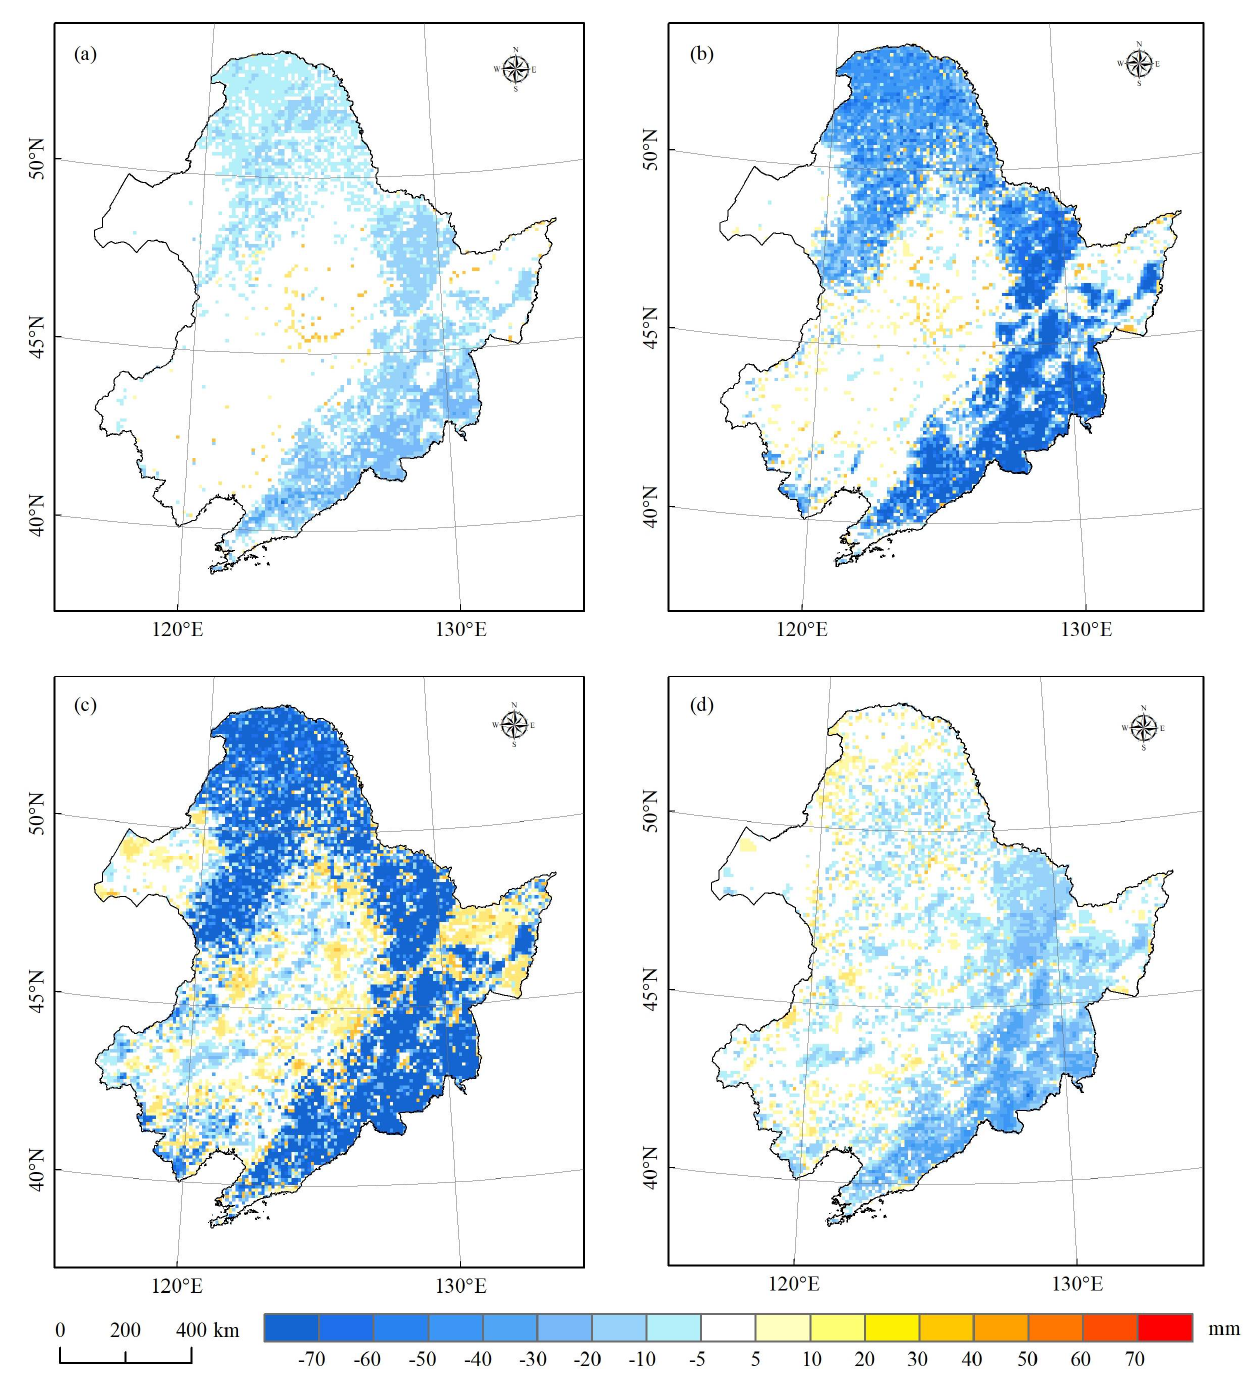
Figure 5. Differences (all-grassland scenario minus the forested scenario) in evapotranspiration (mm) in December–January–February ( a ) March–April–May ( b ) June–July–August ( c ) and September–October–November ( d ) between the forested and all-grassland scenarios.